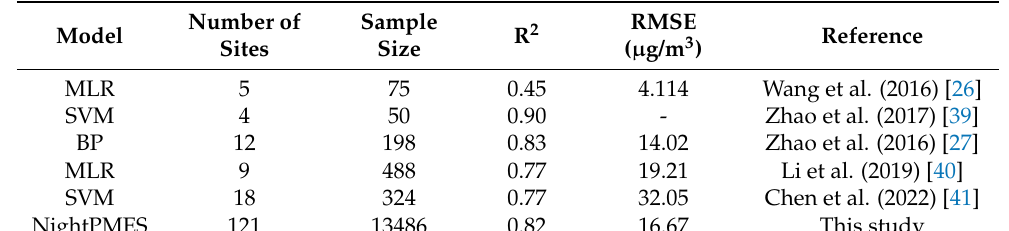
Table 6. Statistics of the models for estimating the nighttime PM 2.5 concentration based on the VIIRS/DNB data.